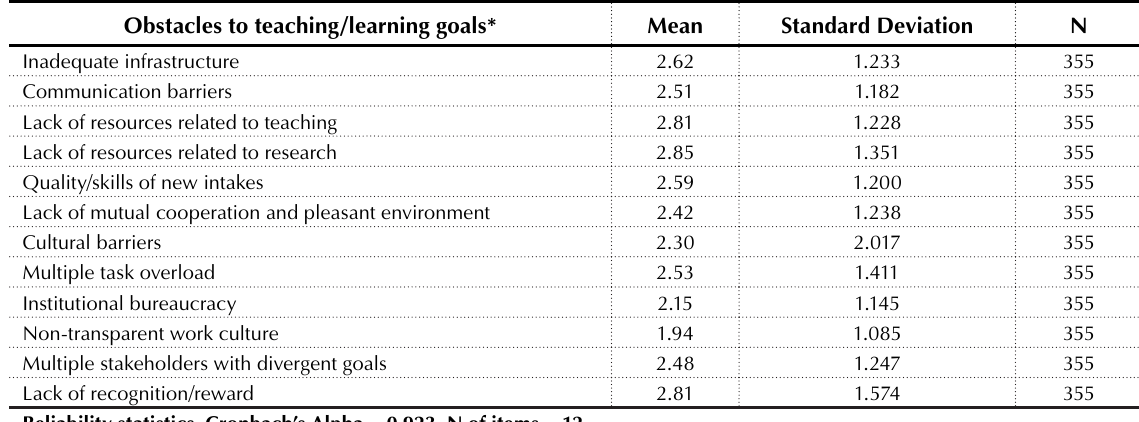
Table 4. Reliability test: obstacles in meeting goals of teaching and learning (n = 456) Obstacles to teaching/learning